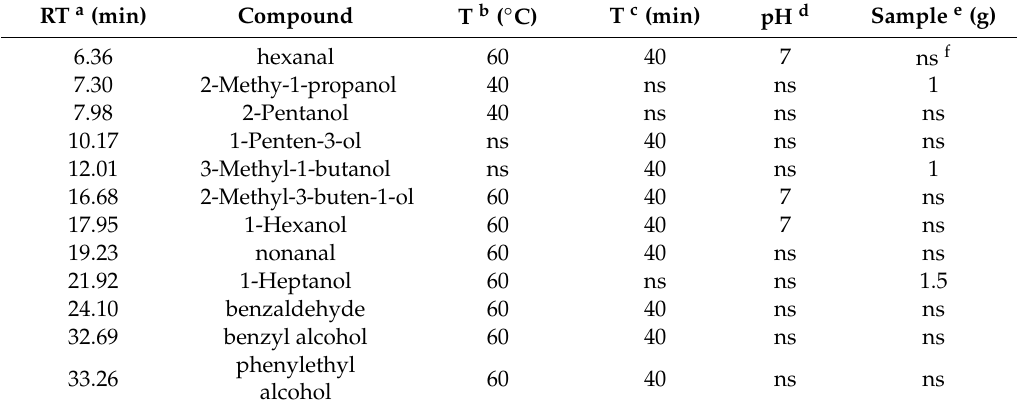
Table 2. Results of the factorial design: optimal extraction conditions based on the regression models for the factors that significantly influenced extraction ( p <